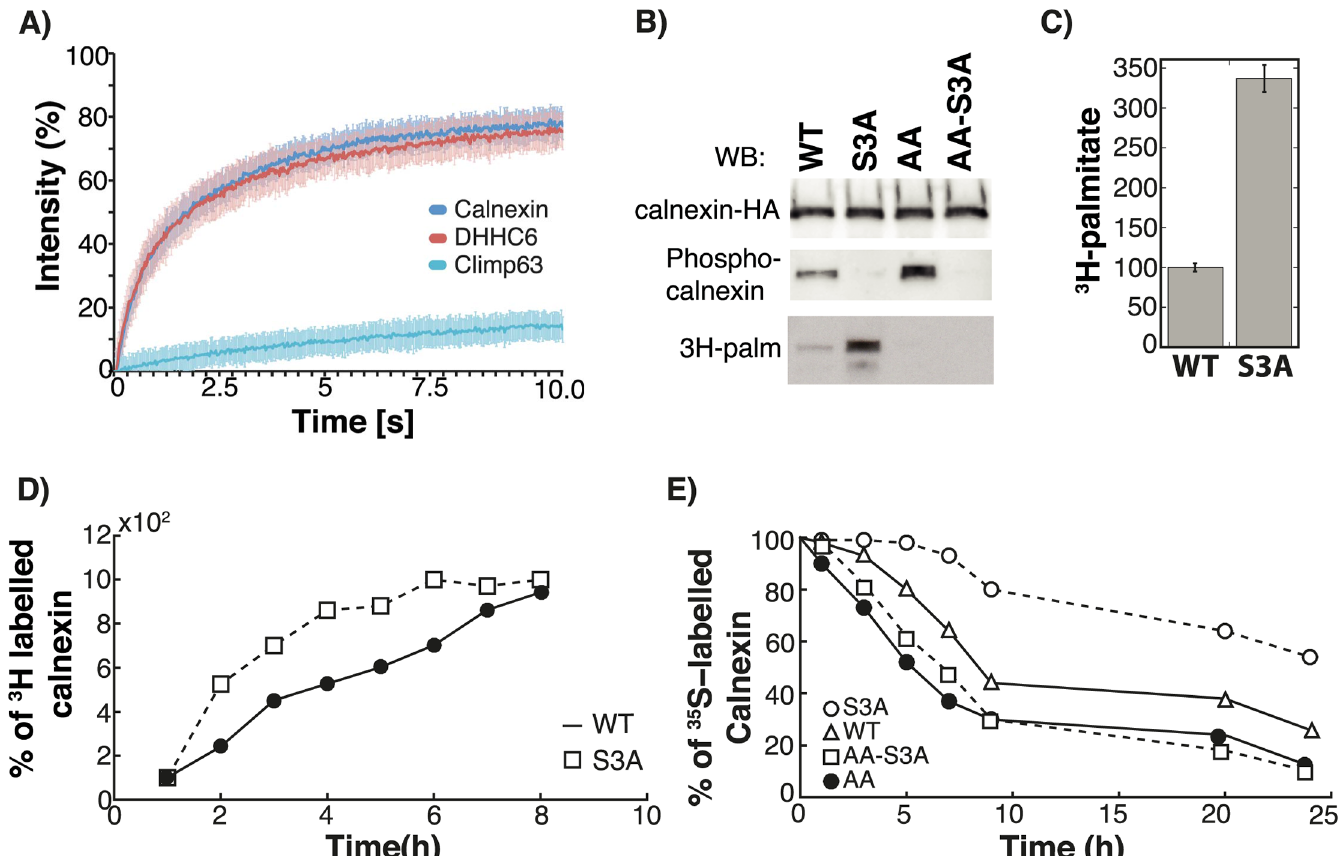
Fig 7. Premature calnexin palmitoylation is prevented by serine phosphorylation. A: Hela cells were transfected 48 hrs with Calnexin-GFP, GFP-DHHC6 or GFP-Climp63. Cells were submitted to FRAP analysis (see Material and Methods). B-E: HeLa cells were transfected for 24h with calnexin- WT-HA, calnexin-S3A-HA, calnexin-AA-HA or calnexin-AA-S3A-HA. C: Cells were incubated with 3 H-palmitic acid for 2h, washed prior to immunoprecipitation using anti-HA antibodies. Immunoprecipitates were split into two, run on SDS-PAGE and analyzed either by autoradiography ( 3 H- palmitate) or Western blotting (anti-HA or anti phospho-calnexin). Autoradiograms were quantified using the Typhoon Imager (Image QuantTool, GE healthcare). Errors correspond to standard deviations (n = 3). D: Cells were incubated with 3 H-palmitic acid for different hours at 37°C, washed prior to immunoprecipitation using anti-HA antibodies. Immunoprecipitates were split into two, run on SDS-PAGE and analyzed either by autoradiography ( 3 H- palmitate) or Western blotting and autoradiograms were quantified using the Typhoon Imager (Image QuantTool, GE healthcare). E: Cells were incubated 20 min pulse at 37°C with 35 S-methionine/cysteine, washed and further incubated for different times at 37°C. Calnexin were immunoprecipitated and analyzed by SDS-PAGE. Autoradiography and western blotting were quantified using the Typhoon Imager (Image QuantTool, GE healthcare).